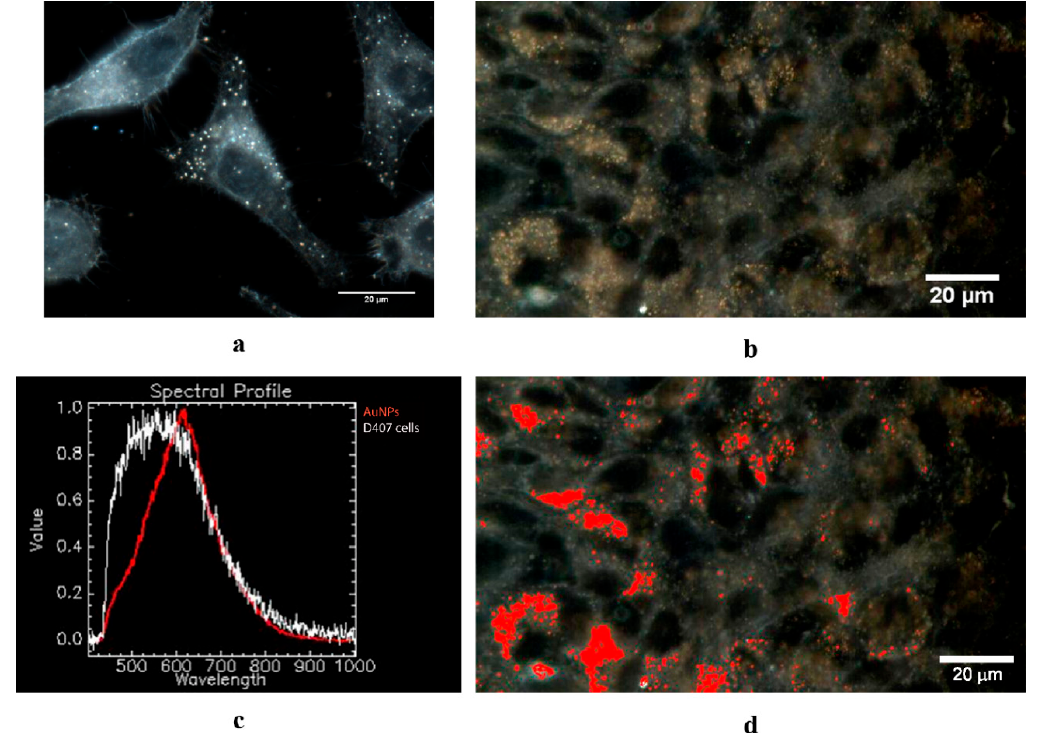
Figure 7. ( a ) Enhanced dark field hyperspectral images of control D407 cells. Scale bar: 20 nm, magnification 100×. ( b ) Hyperspectral image of AuNPs within D407 cells; ( c ) spectral profile of AuNPs and D407 cells; ( d ) AuNP spectra (red) mapped in D407 cells.